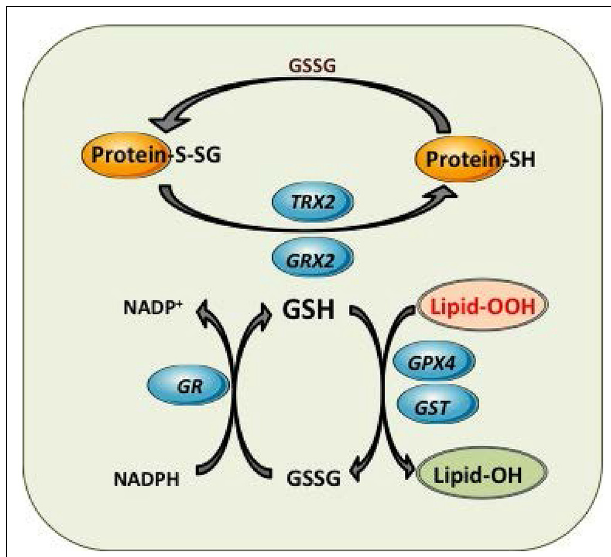
FIGURE 3 | Mitochondrial GSH redox cycle and interaction with other antioxidant defenses. Detoxification of harmful lipid peroxides (Lipid-OOH) to their corresponding hydroxides (lipid-OH) by glutathione peroxidase 4 (GPX4) and glutathione- S -transferases (GST). Control of mitochondrial protein glutathionylation (Prot-S-SG, Prot -SH) by glutaredoxin (GRX2) and thioredoxin 2